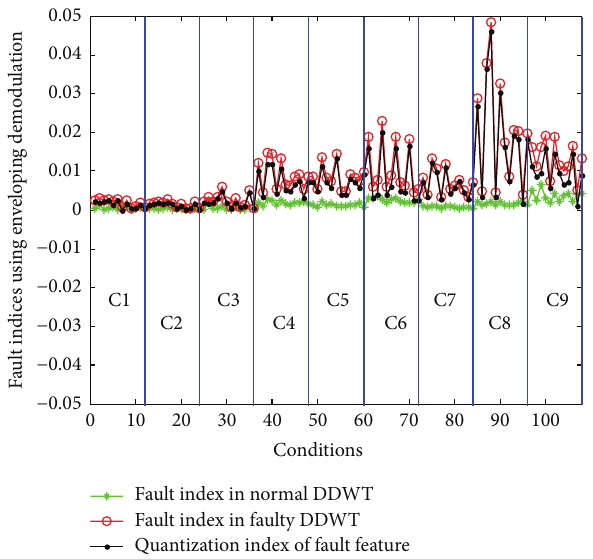
Figure 18: Fault indices using enveloping